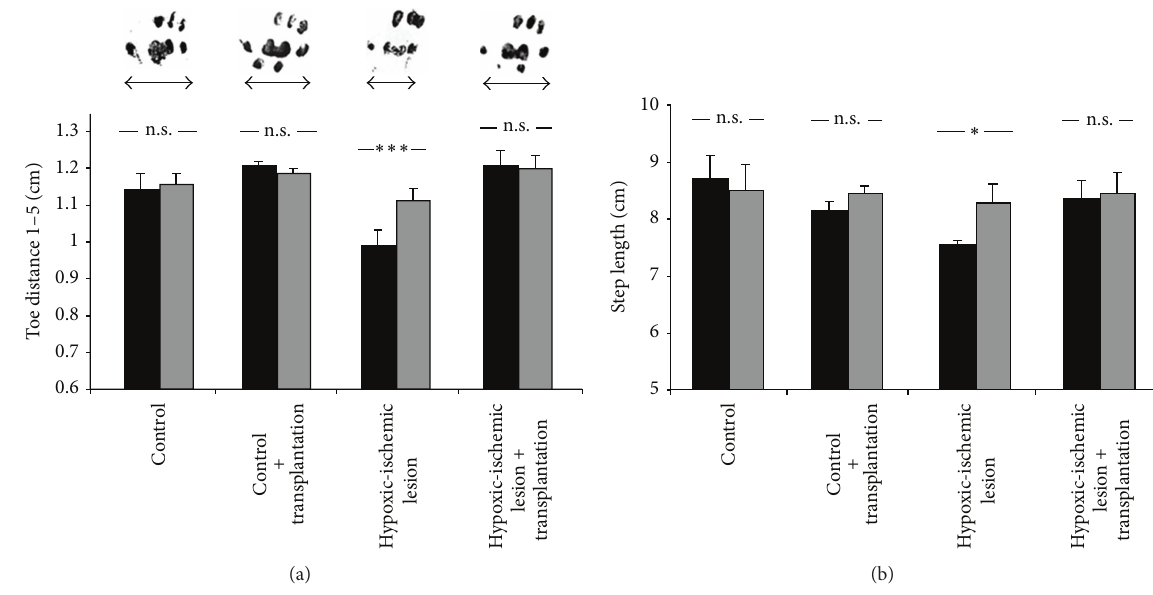
Figure 2: Transplantation of hUCB-derived mononuclear cells reduces spastic paresis as assessed by footprint analysis of 3-wk-old animals (see [17, Figure 5]). (a) Hypoxic-ischemic brain damage results in spastic paresis of the distal limb muscles, causing a significant reduction of footprint width (toe distance 1 to 5) of the right hind paw (contralateral to the insult; black columns ) compared with the left (ipsilateral; gray columns ) hind paw. Intraperitoneal transplantation of hUCB-derived mononuclear cells after hypoxic-ischemic brain damage reduced spastic paresis. In these animals, differences between ipsi- and contralateral hind paws were no longer detectable. Photographs of footprints (right hind paws) illustrate the footprint widths ( arrows ) of control animals without ( left ) and with ( center left ) transplantation, upon hypoxic-ischemic lesion without ( center right ) and with ( right ) transplantation of hUCB-derived mononuclear cells. (b) In control animals with and without transplantation, the step length of left and right hind paws is equal. In contrast, hypoxic-ischemic lesion resulted in a significantly reduced step length of the right hind paw ( black columns ) compared with the left hind paw ( gray columns ). This reduction in step length of the hind paw contralateral to the lesion, also indicative of spastic paresis, was largely alleviated upon transplantation of hUCB-derived mononuclear cells. Data are presented as mean ± SEM; ∗ 𝑃 < 0.05 ; ∗∗∗ 𝑃 < 0.001 . This paper is available online